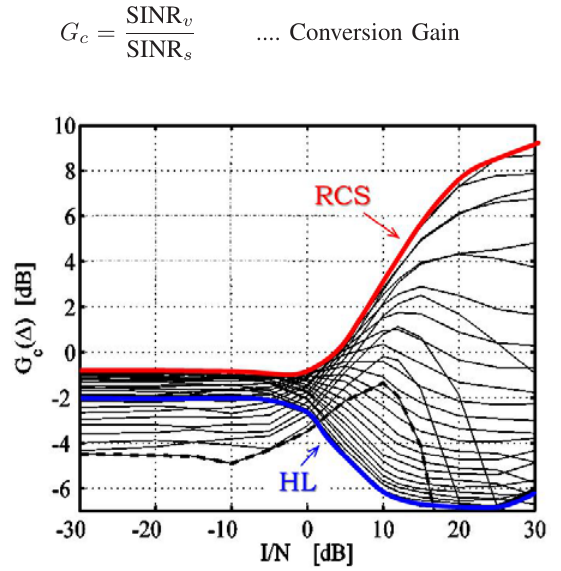
Fig. 7. Comparison of the conversion-gains for RCS and